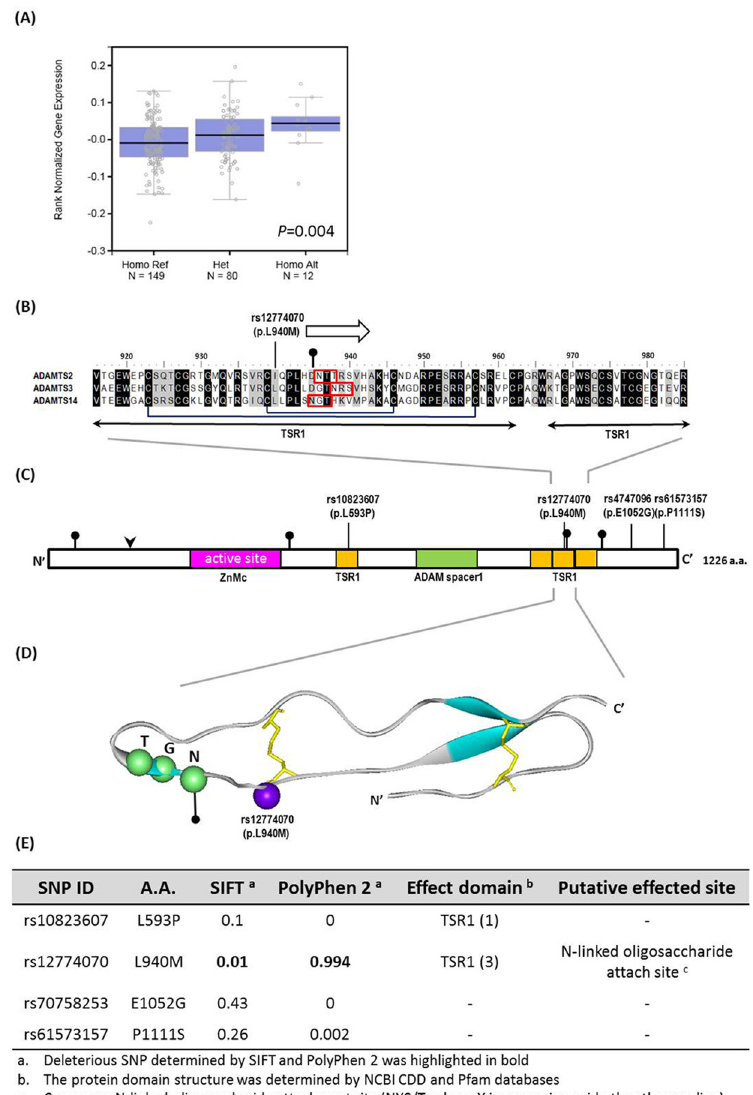
Fig 1. Functional implication and In silico profiling of ADAMTS14 SNP rs12774070. (A) ADAMTS14 displays a significant eQTL association with rs12774070 genotypes in esophagus mucosa tissues (GTEx data set). ( B ) The altered residue is conserved throughout three procollagen aminopropeptidase subfamily of ADAMTS proteases, including ADAMTS2 (NP_055059.2), ADAMTS3 (NP_055058.2) and ADAMTS14 (NP_631894.2), as shown by alignment of the protein sequences with Crustal Omega software. Numbering is for human ADMDTS14. The arrow represents b-strands, and consensus sites for N-liked oligosaccharide attachment are marked in red (pinpointed). The disulfide bonds are marked in dark lines connecting paired cysteines. ( C ) Schematic representation of the full-length human ADMDTS14 protein, domain symbols are drawn approximately to scale. The rectangles represent the key domain structures, ZnMc superfamily (cd04273; pink), ADAM spacer1 (pfam05986; green) and four TSR1 (smart00209; yellow) by NCBI CDD server. Putative furin cleavage site is indicated by an arrowhead, and N-linked glycosylation sites are pointed by pins. ( D ) Ribbon diagram depicts the homology model of TSR1 (3) domain of ADAMTS14. The ribbon indicates the C α carbon of the TSR1 domain characterized in this study. The blue ribbon, purple sphere, green spheres and yellow sticks indicate the b-strands structure, SNP rs12774070, potential N-linked glycosylation site and disulfide bonds, respectively. ( E ) Pathogenicity prediction of ADAMTS14 SNPs assessed in this